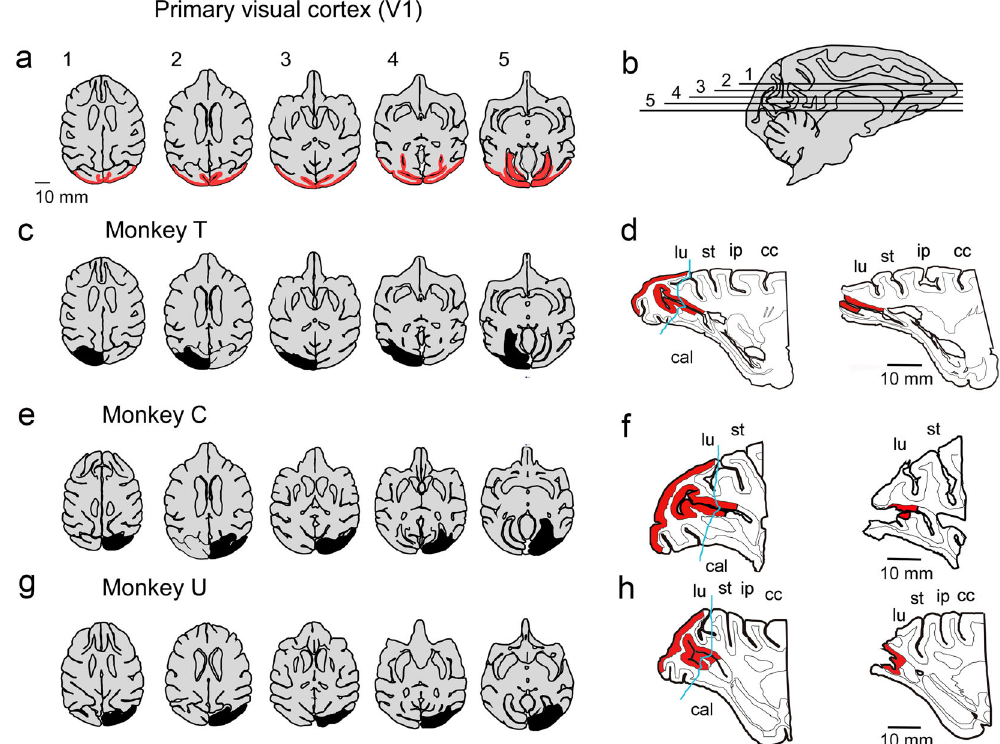
Fig. 1 Lesion extent in the individual animals. a The area of V1 in horizontal planes (colored in red). b Horizontal levels of the section in each panel of a with the corresponding numbers, overlaid on a sagittal brain slice. c , e , g The extent of the V1 lesion in monkeys T, C, and U is indicated on the horizontal planes in black, respectively. The horizontal levels of the individual horizontal sections in c , e , and g are matched with those in a . d , f , h The sagittal planes across the calcarine sulcus (cal) on the contralesional (left panel) and ipsilesional (right panel) side in monkey T, C, and U, respectively. The extent of V1 is indicated in red. Posterior (leftward) side of the blue lines (indicated in the arrow) in the left panels was considered to be lesioned on the ipsilesional side (right panel). cal calcarine sulcus, cc central sulcus, ip intraparietal sulcus, lu lunate sulcus, st superior temporal